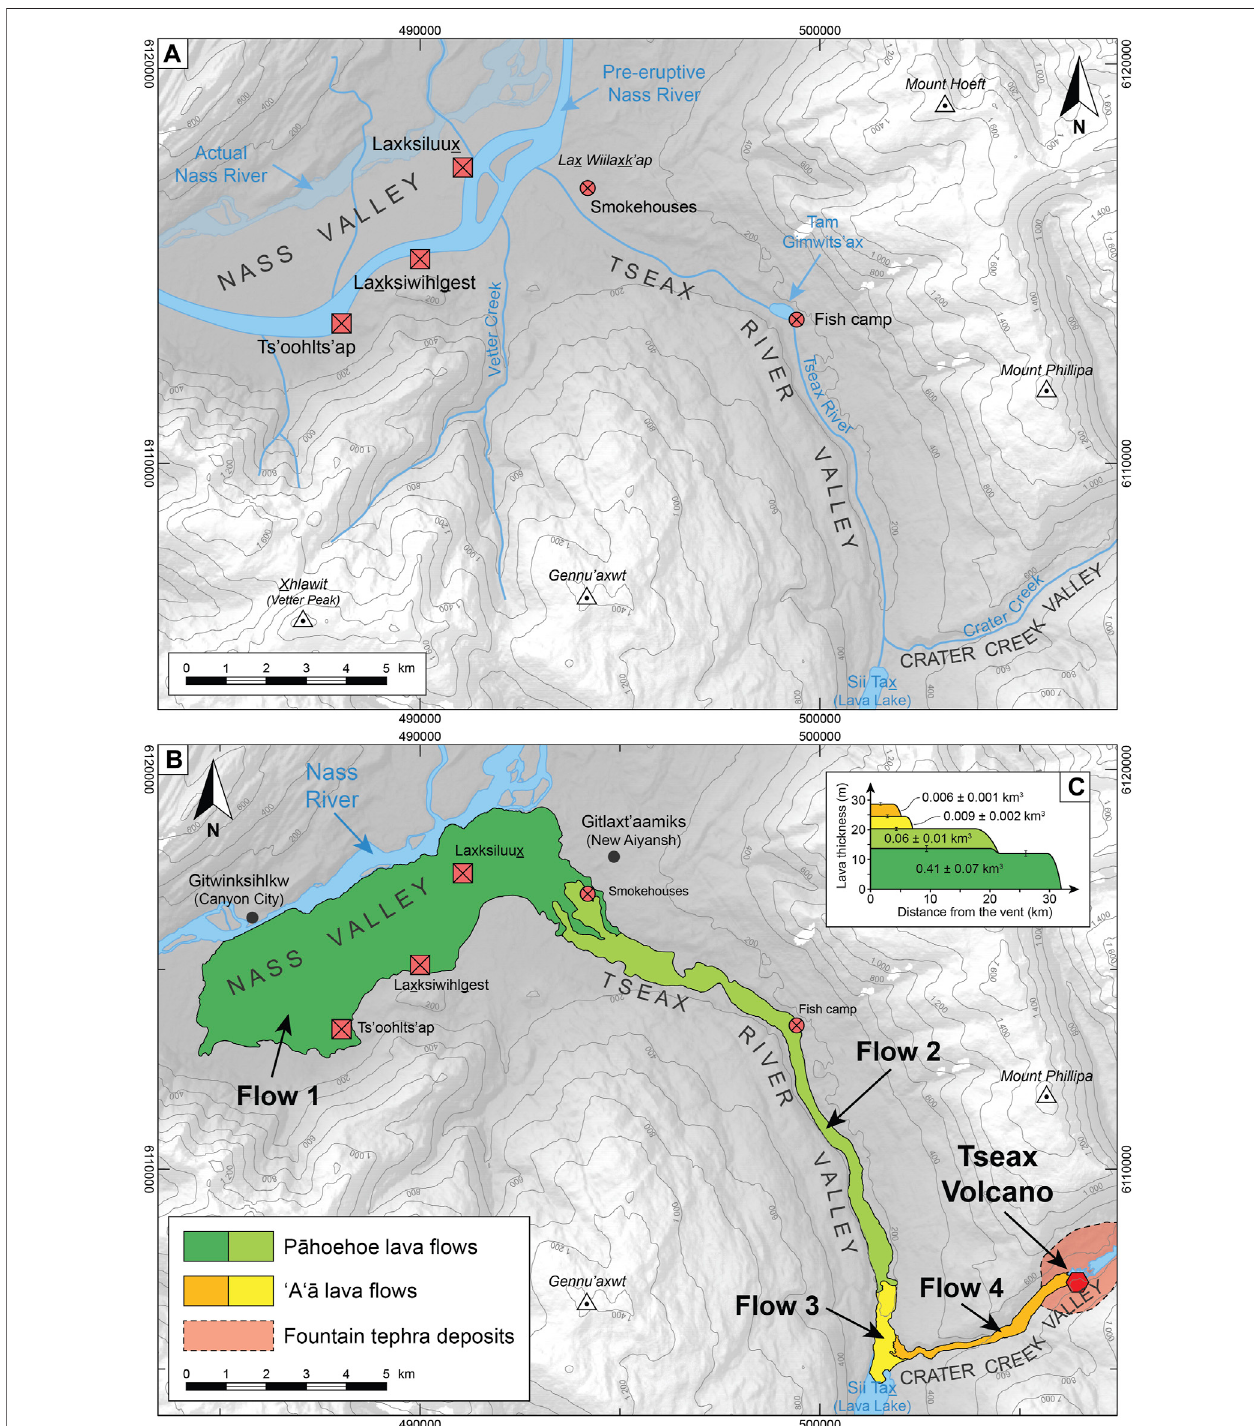
FIGURE2|(A) Pre-eruption geographyoftheTseaxarea.TheapproximatelocationsoftheformerNisga ’ avillages,smokehousesand fi shcampsarealsoshown. Extensively modi fi ed from Nisga ’ a Tribal Council and B.C. Parks Committee. (1997). (B) Simpli fi ed map of the Tseax lava fl ow fi eld. The lava fi eld is divided into four lava fl ows: 2 p ā hoehoe lava fl ows (Flow 1 and Flow 2) and 2 ‘ a ‘ ā lava fl ows (Flow 3 and Flow 4). Coordinates system: UTM Projection Zone 9N, WGS 1984 Datum. Modi fi ed after Le Moigne et al. (2020). (C) Simpli fi ed stratigraphy of the lava fl ow fi eld. Vertical exaggeration: 550×.